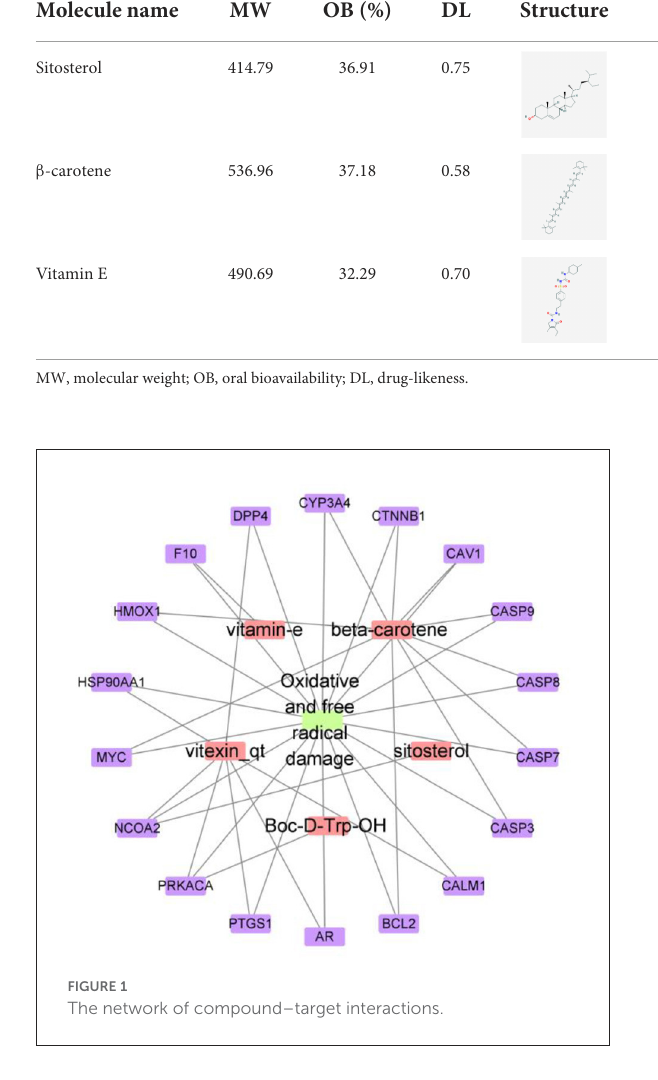
(Perera and Yen, 2007; Eggersdorfer and Wyss, 2018; Li et al., 2021). The antioxidant activity of β -carotene was determined using the reducing power assay, which is discussed in the following experiments.